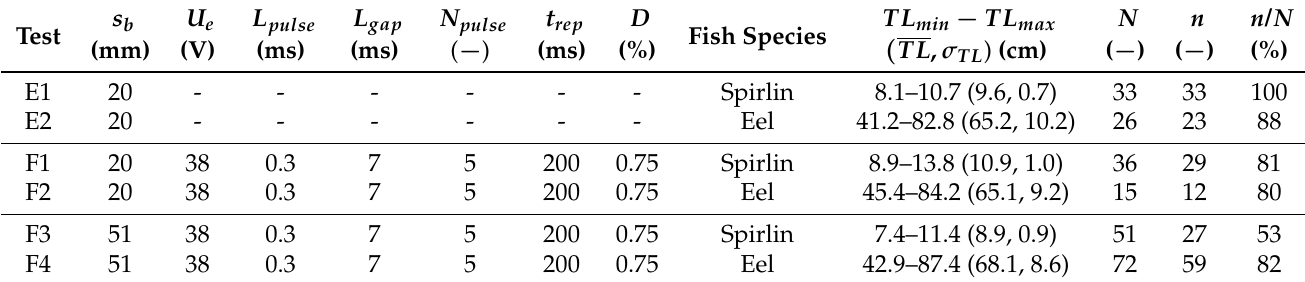
Table 1. Test program of live fish tests with eel ( Anguilla anguilla ) and spirlin ( Alburnoides bipunctatus ) with a horizontal bar rack (E1 and E2) and an electrified horizontal bar rack (F1–F5). The characteristics of each configuration are defined by the bar spacing s b , applied voltage U e , pulse length and gap length L pulse and L gap , number of pulses N pulse , repetition time t rep , duty cycle D , fish total length TL (minimum, maximum and average), standard deviation σ TL , total number of individuals tested per configuration N and the total number of active fish n (fish that swam into the observation